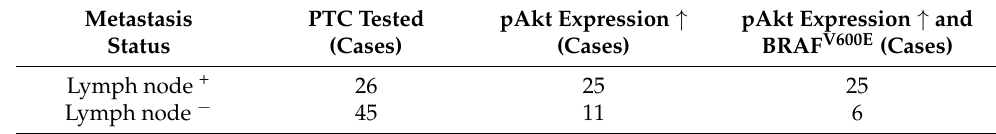
Table 1. The pAkt elevation is relevant to lymph node metastasis and BRAF mutation status.